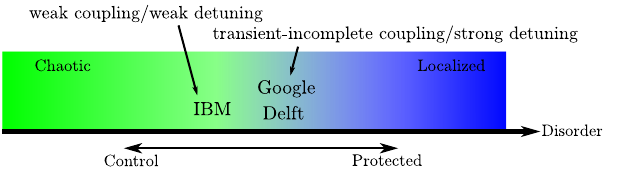
Fig. 2 | A schematic of the tension map between optimally protecting and ef fi cientlyoperating. Utilizingthemeasuresbasedonthemany-bodylocalization, we seethat different quantum processormanufacturershavesettled upon varying architectural design protocols with both bene fi ts and downfalls with respect to control and protection. The schematic is based on results of ref.